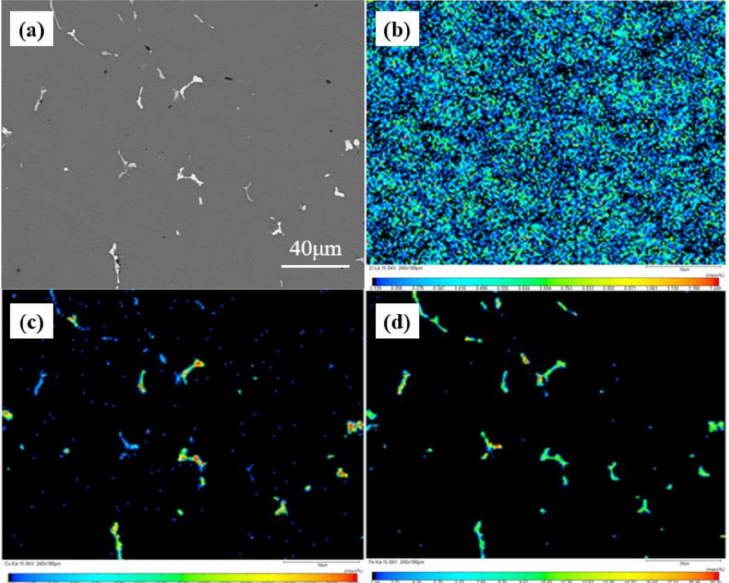
Figure 12. BSE of UT-SC sample of alloy C after solution treatment ( a ) and its electron microprobe elemental map ( b ) Zr; ( c ) Cu; ( d )